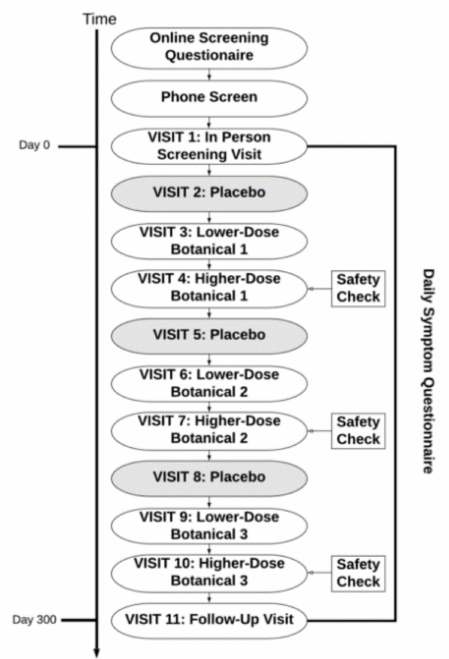
Figure 1. Study protocol. Each participant completed testing of up to three botanicals. For each botanical, there was a placebo condition, followed by lower-dose botanical and higher-dose botanical conditions. The period of time between visits was 30 ± 3 days. Some participants re-enrolled in the study after completion, receiving up to a maximum of six